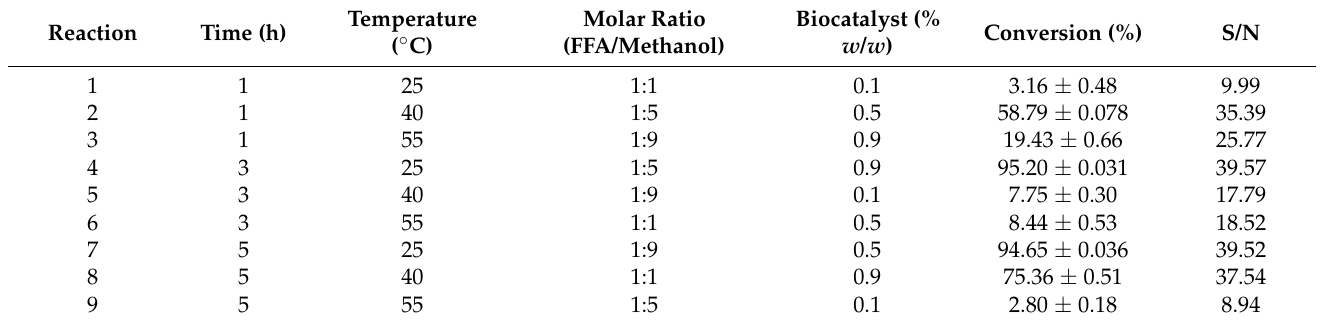
Table 1. Experimental Taguchi design for the production of methyl esters from babassu.